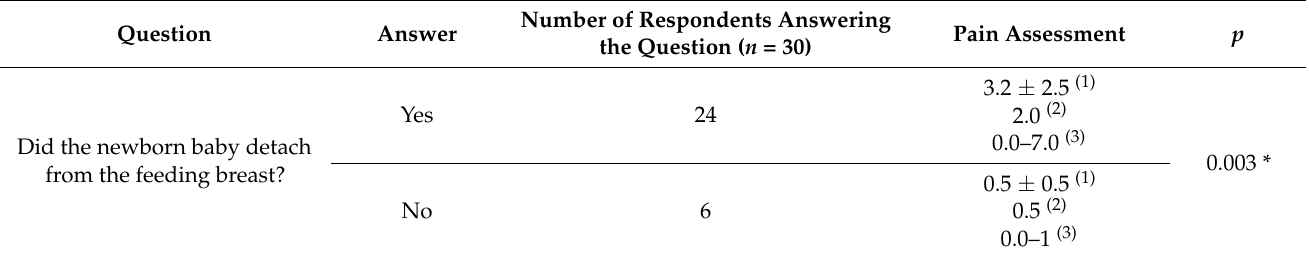
Table 3. The relationship between pain assessment and the answer to question no. 1.